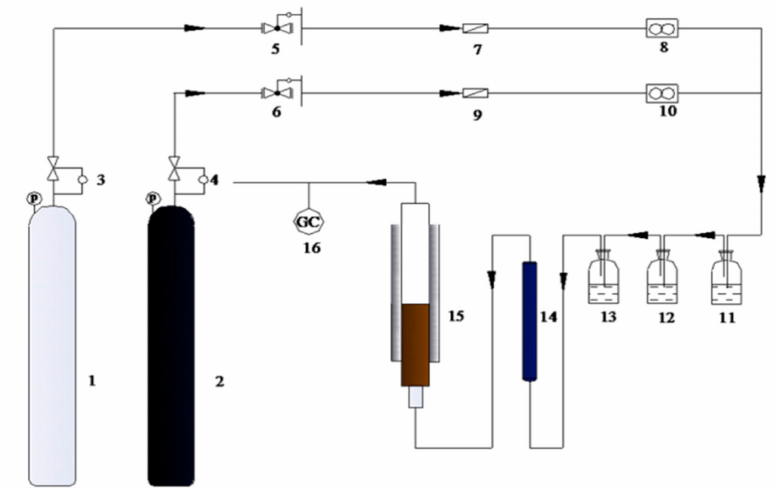
Figure 11. Schematic diagram of the C 2 H 2 dimerization system: 1 C 2 H 2 ; 2 N 2 ; 3,4 partial pressure valve; 5,6 check valve; 7,9 gas filter; 8,10 mass flow controller; 11 K 2 Cr 2 O 7 solution; 12 Na 2 S 2 O 4 solution; 13 NaOH solution; 14 drying tube; 15 reactor; 16 Gas Chromatograph